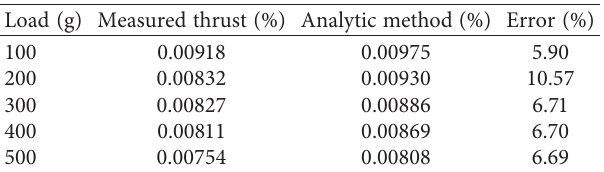
Figure 24: Thrust comparison diagram of different loads of motor with a speed of 0.08m/s: (a) 0.08m/s, 0.1kg; (b) 0.08 m/s, 0.2kg; (c) 0.08m/s, 0.3kg; (d) 0.08m/s, 0.4kg; (e) 0.08m/s, 0.5 kg. Table 5: Thrust fluctuation rate of motor with speed of 0.08m/s under different